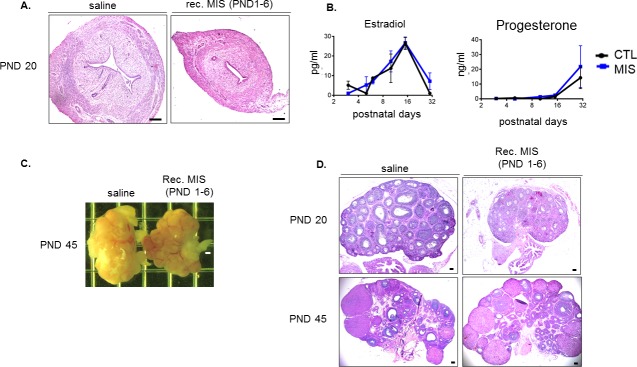
Neonatal exposure to MIS causes uterine hypoplasia but does not affect sex steroid levels or ovarian function.(A) Rat pups were treated with recombinant MIS protein daily from PND1-6 and their uteri were analyzed on PND20, showing evidence of hypoplasia and absence of endometrial glands. (B) Rat pups were treated with empty vector control (CTL) or with AAV9-MIS (MIS) on PND1. Estradiol (left) and progesterone (right) serum levels from CTL and MIS-treated rats at different developmental time points (PND3, 5, 6, 10, 15, 30) (n > 2 both for the control and treated serum). (C) Rat pups were treated with recombinant MIS protein (or vehicle control) from PND1-6, to examine gross ovarian morphology, and (D) ovarian histology from H and E sections at PND 20 and PND45. Scale bars = 50 µm.